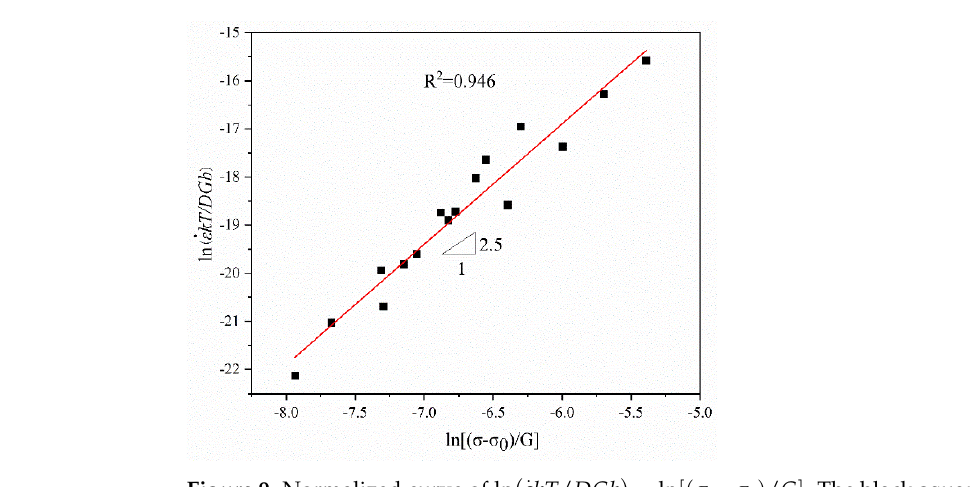
Figure 9. Normalized curve of ln(𝜀(cid:4662)𝑘𝑇/𝐷𝐺𝑏) − ln[(𝜎 − 𝜎 (cid:2868) )/𝐺] . The black squares are data points.